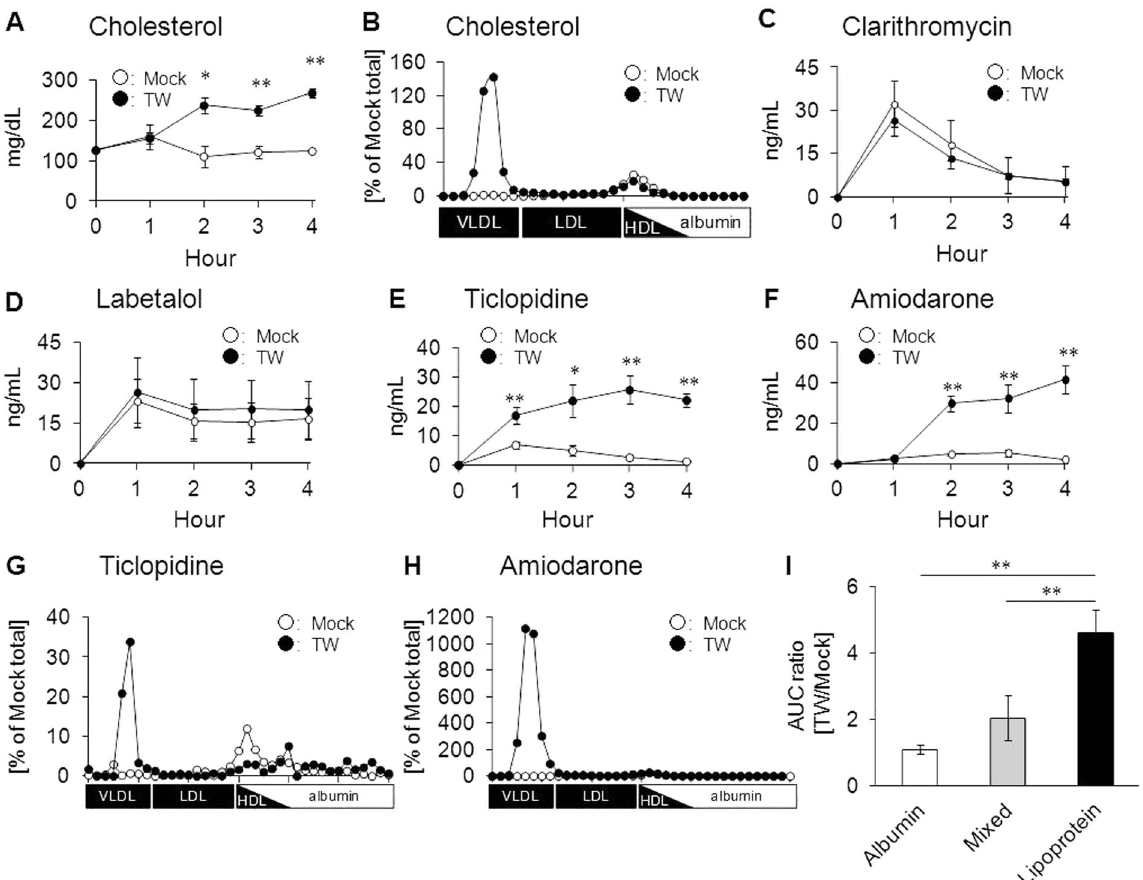
Figure 2. Effect of lipoprotein metabolism modification on the behavior of lipoprotein-associated drugs. (A ) Serum cholesterol concentrations after intravenous administration of saline (Mock) or Triton WR-1339 (TW), which inhibits the conversion of VLDL to LDL. (B) Association of cholesterol with lipoproteins at 4 h after TW treatment. (C–F ) Serum drug concentrations after TW treatment. ( C ) Clarithromycin; ( D ) labetalol; ( E ) ticlopidine; and ( F ) amiodarone. ( G–H ) Analysis of the association of (G ) ticlopidine and (H ) amiodarone with lipoproteins at 4 h after TW treatment. (I) AUC ratios for albumin-bound drugs (albumin), lipoprotein- associated drugs (lipoprotein), and mixed-type drugs (mixed). Bars represent the mean ± s.e.m. * p < 0.05, ** p <